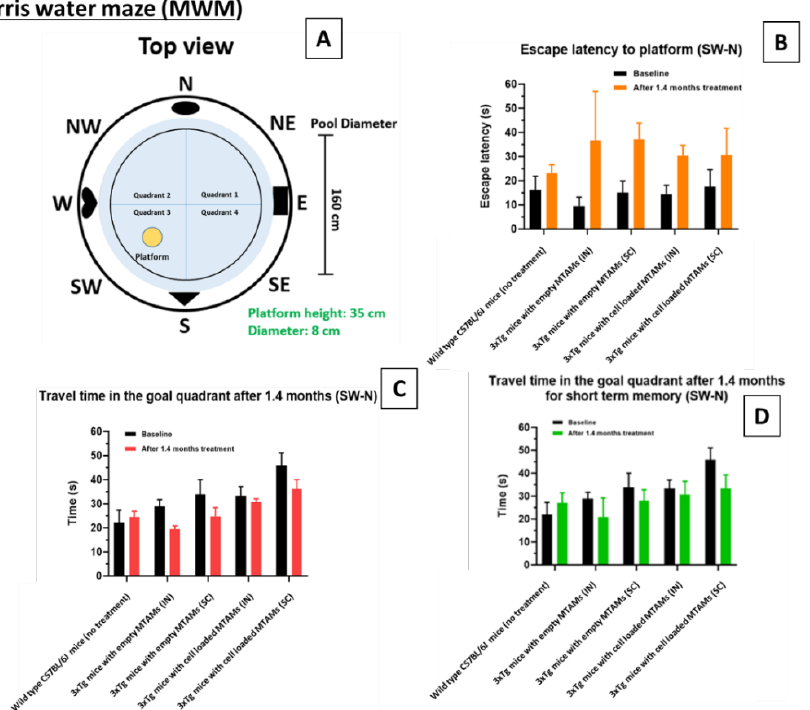
Figure 4. Morris water maze escape latency of the respective models. ( A ) Design of the Morris water maze. The respective study groups were assessed with this system, namely wild-type (without treatment), intracranially (IN) implanted empty PSF MTAMs, subcutaneously (SC) implanted empty PSF MTAMs, IN implanted hybridoma loaded PSF MTAMs, and SC implanted hybridoma loaded PSF MTAMs. ( B ) Escape latency of the respective mouse model study groups analyzed with Two-way ANOVA Tukey’s multiple comparisons tests (Empty MTAMs vs cell loaded: IN group p -value = 0.37; SC group p -value = 0.58). ( C ) Travel time in the goal quadrant (long term memory testing): mouse models of the study groups with IN and SC implanted with hybridoma PSF MTAMs registered a value of 33 ± 11 s and 46 ± 10 s respectively (baseline). After 1.4 months, this value reduced to 31 ± 4 s and 36 ± 8 s respectively. ( D ) Travel time in the goal quadrant (short term memory testing): the mouse models receiving hybridoma cell loaded PSF MTAMs that were implanted IN and SC registered a reading of 30 ± 12 s and 31 ± 22 s respectively, after 1.4 months of treatment.